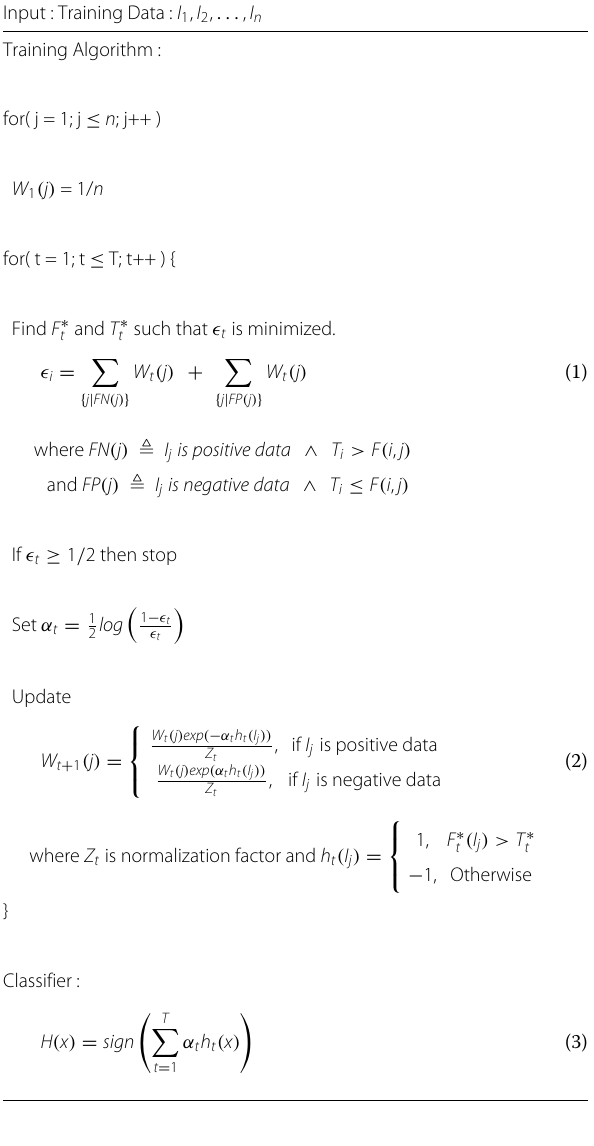
Table 1 Adaboosting